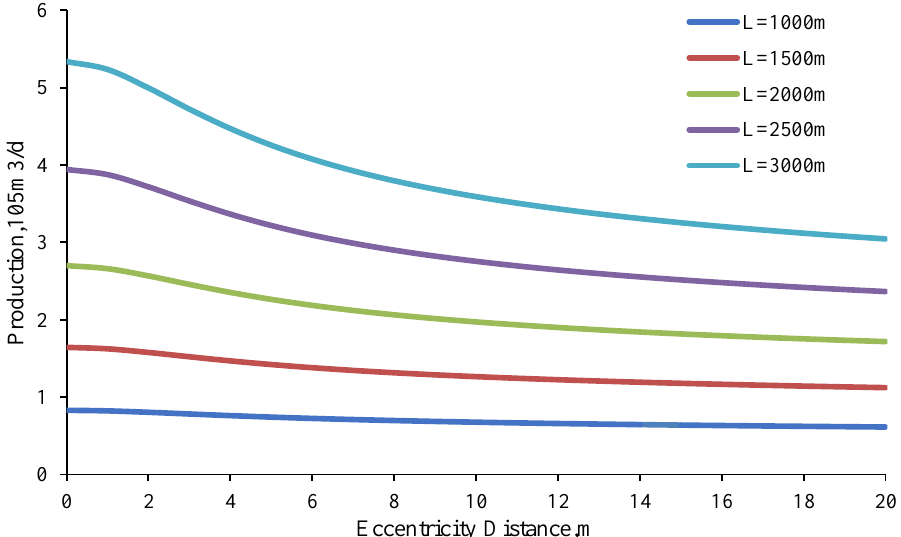
Figure 9—Effect of the eccentricity distance on production at different horizontal well length Formation damage. Figure 10 depicts the influence of formation damage. It indicates that the longer the horizontal well is, the more impact of skin factor( S ) on horizontal well